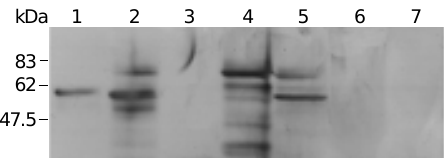
Figure 2 - Immunoblots with anti-PLC-a mouse serum. Lane 1 , Recombinant protein eluted from the gel. Lane 2 , Extract of E. coli BL21(DE3) transformed with pET23a harboring the complete plc-a fragment. Lane 3 , E. coli BL21(DE3) transformed with non-recombinant pET23a. Lane 4 , E. coli JM101 transformed with pGEX-5T har- boring the complete plc-a ORF fragment. Lane 5 , E. coli JM101 transformed with pGEX-5T harboring the plc-a ORF fragment without the 5' region coding for the putative signal peptide. Lane 6 , E. coli JM101 trans- formed with non-recombinant pGEX-5T. Lane 7 , Non- transformed E. coli JM101. Numbers at left indicate molecular mass in